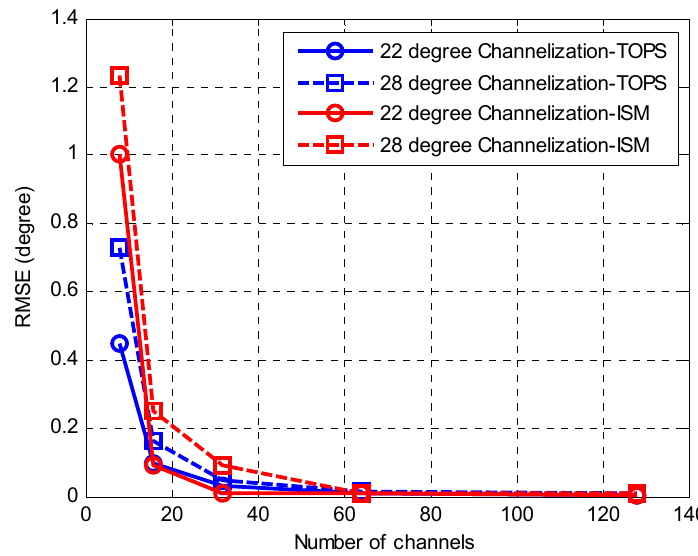
Figure 9. RMSE of the DOA estimates against the number of sub-channels. Figure 10. RMSE of the DOA estimates against the number of sub-channels.